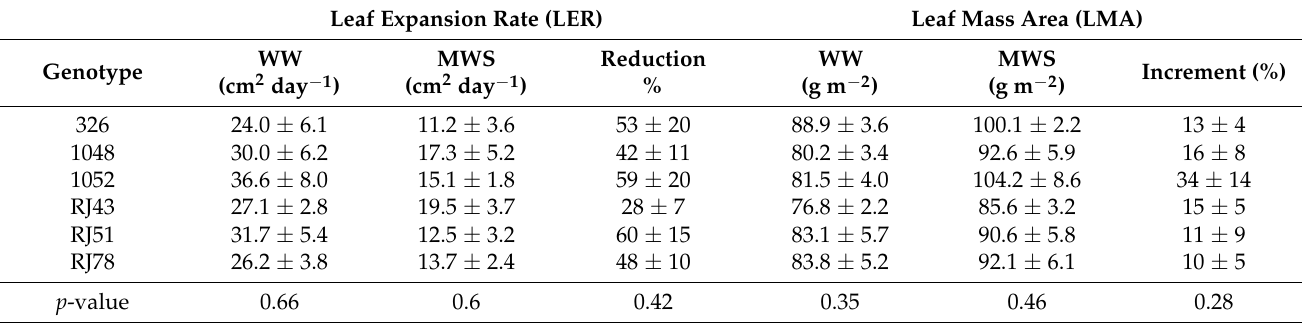
Table 2. Leaf expansion rate (LER) and leaf mass area (LMA) in each irrigation treatment. Leaf Expansion Rate (LER) Leaf Mass Area